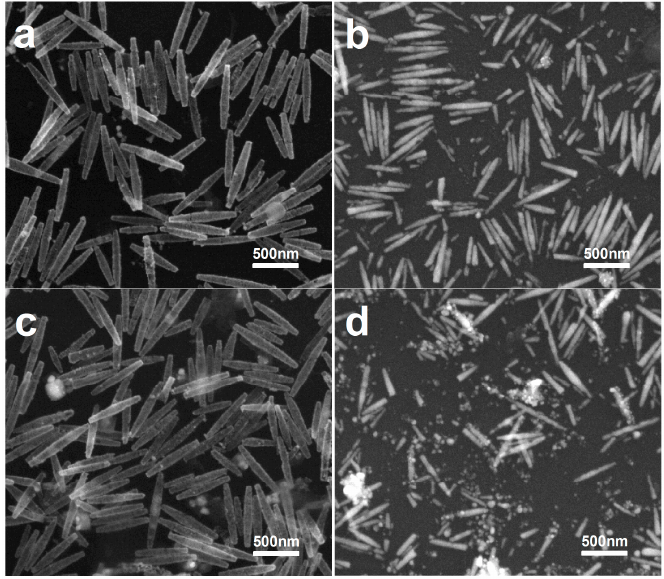
Figure 4. SEM of the alloy and Ag nanorices after being mixed with 3% aqueous H 2 O 2 for different times. ( a ) Ten minutes (alloy nanorices); ( b ) Five minutes (Ag nanorices); ( c ) Five hours (alloy nanorices); ( d ) Ten minutes (Ag nanorices).